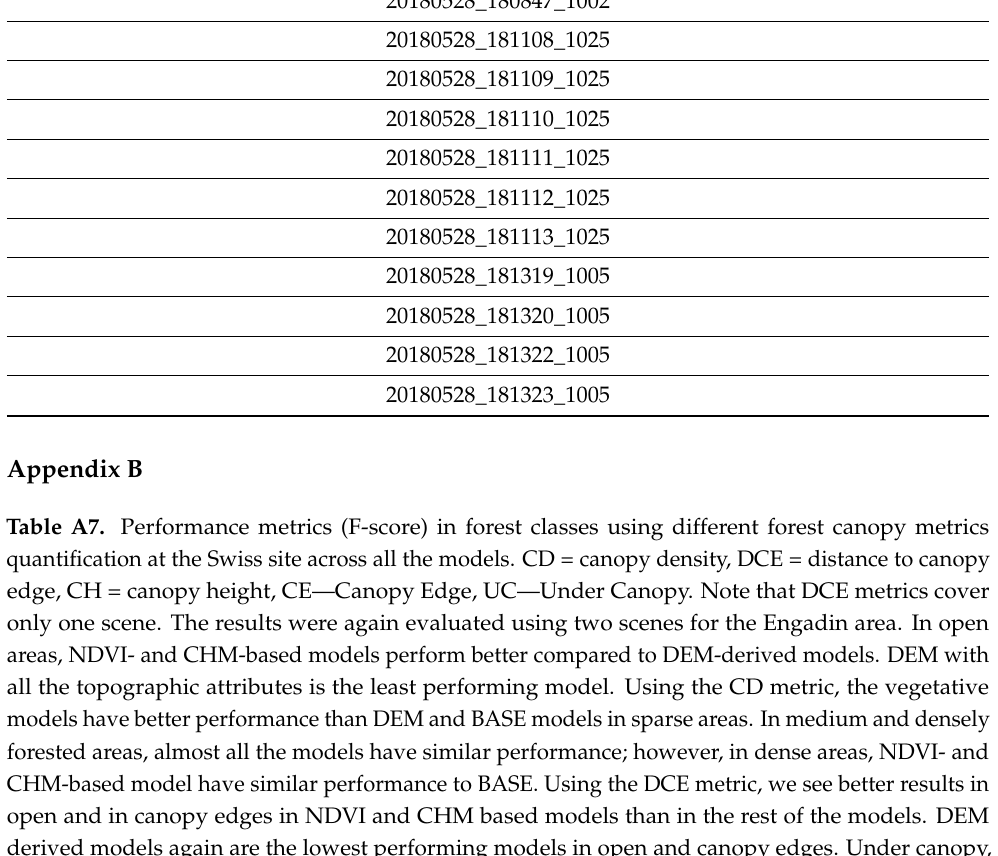
Table A6. 12 Planet Scene IDs (Dove Classic constellation) for Tuolumne Basin, CA, USA.